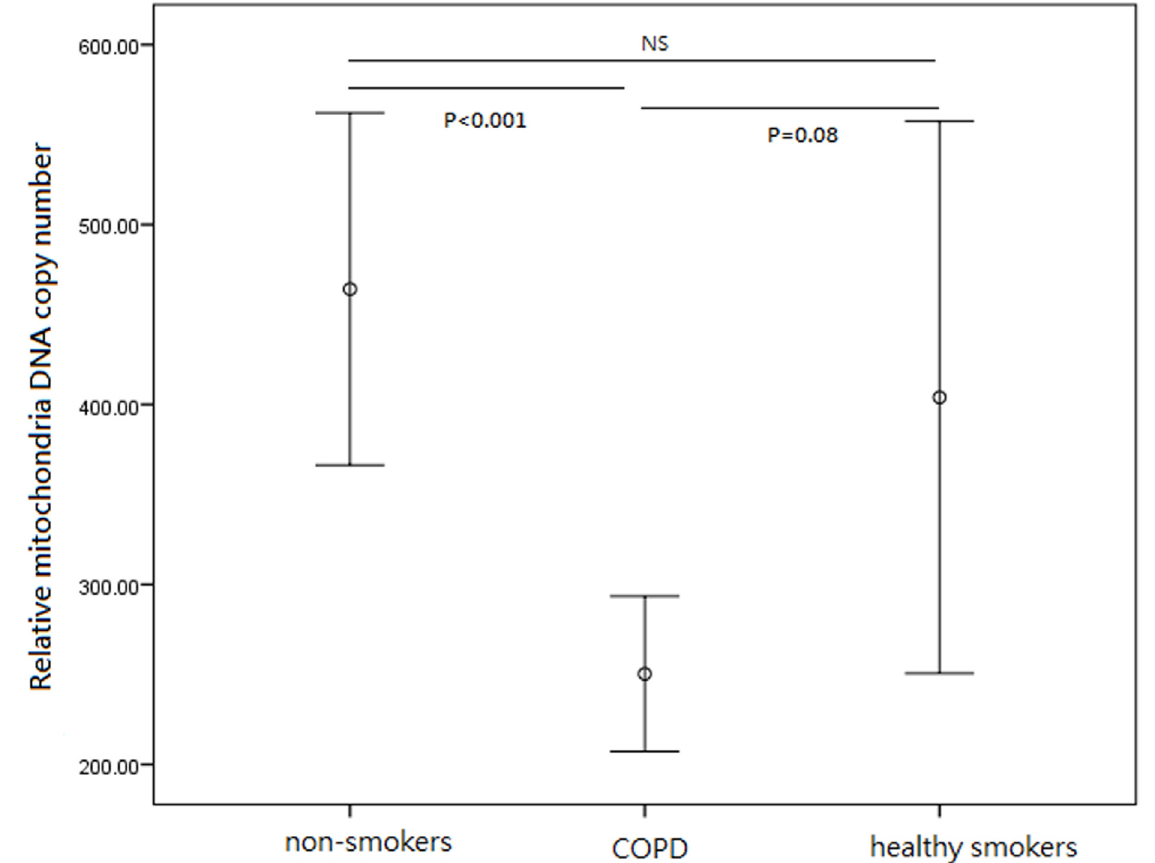
Fig 1. Relative mtDNA copy number of peripheral leukocytes in COPD group, heathy smokers and no-smokers. MtDNA copy number: COPD group (N = 86, 250.3 ± 21.5); heathy smokers group (N = 33, 404.0 ± 76.7); non-smokers group(N = 77, 464.2 ± 49.9). Results are expressed as mean ± standard error. P < 0.001, COPD group vs. non-smokers group; P = 0.08, COPD group vs. heathy smokers group; NS, non-smokers group vs. heathy smokers group.